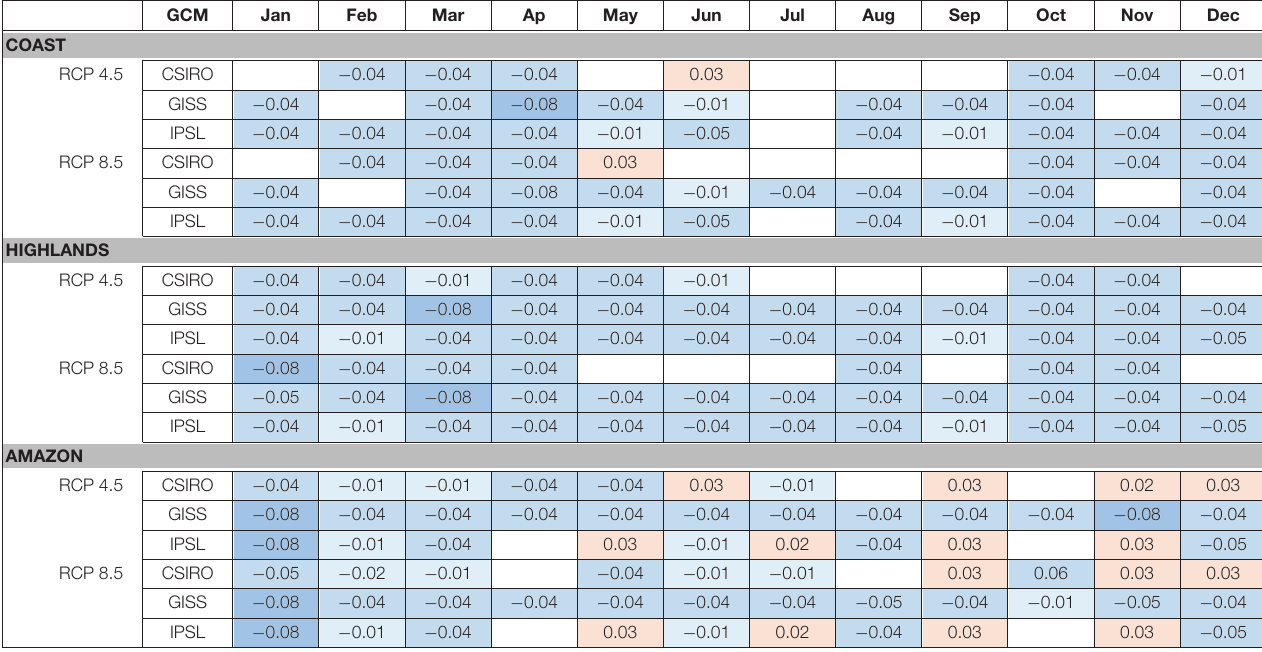
TABLE 6 | Monthly changes of drought probablity for severe